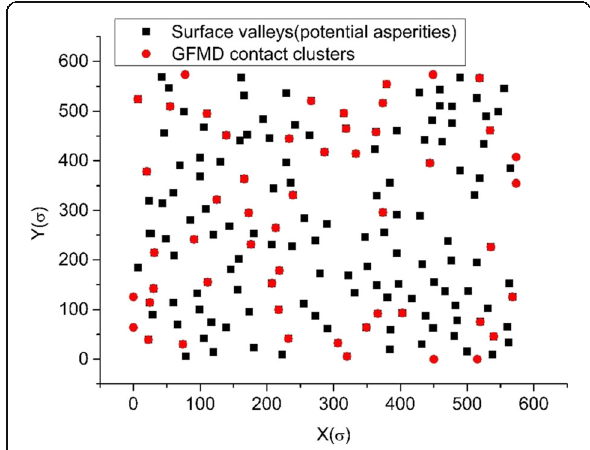
Fig. 7 The locations of the contact clusters and the surface valleys at 10% contact